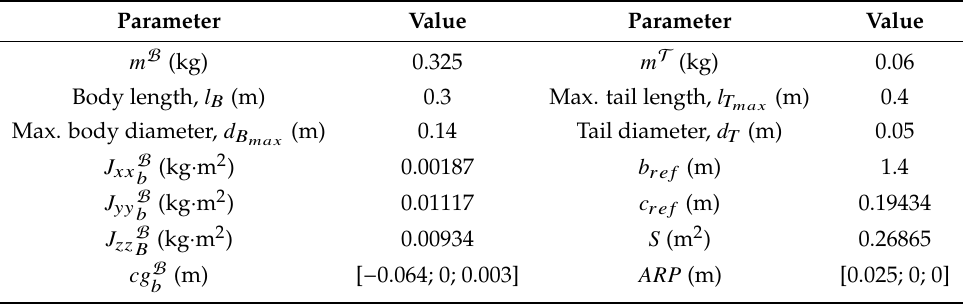
Table 1. Aircraft model physical